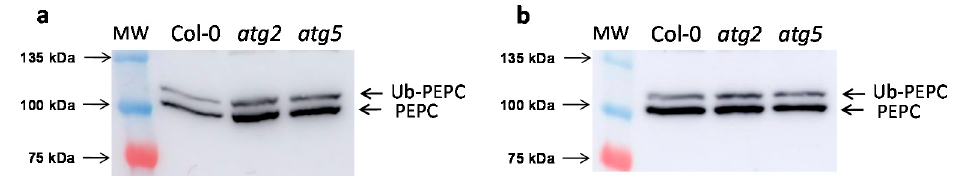
Figure 2. Arabidopsis atg2 and atg5 autophagy-defective SALK lines accumulate PEPC. Leaves from six-week-old Arabidopsis Col-0, atg2 , and atg5 SALK lines were pooled (30 plants for sample). Protein aliquots from crude extracts were analyzed by SDS-PAGE and immunoblotted with anti-PEPC antibodies. ( a ) Results for 5 mU of PEPC from leaf extracts. ( b ) Results for 50 µg of proteins from leaf extracts.